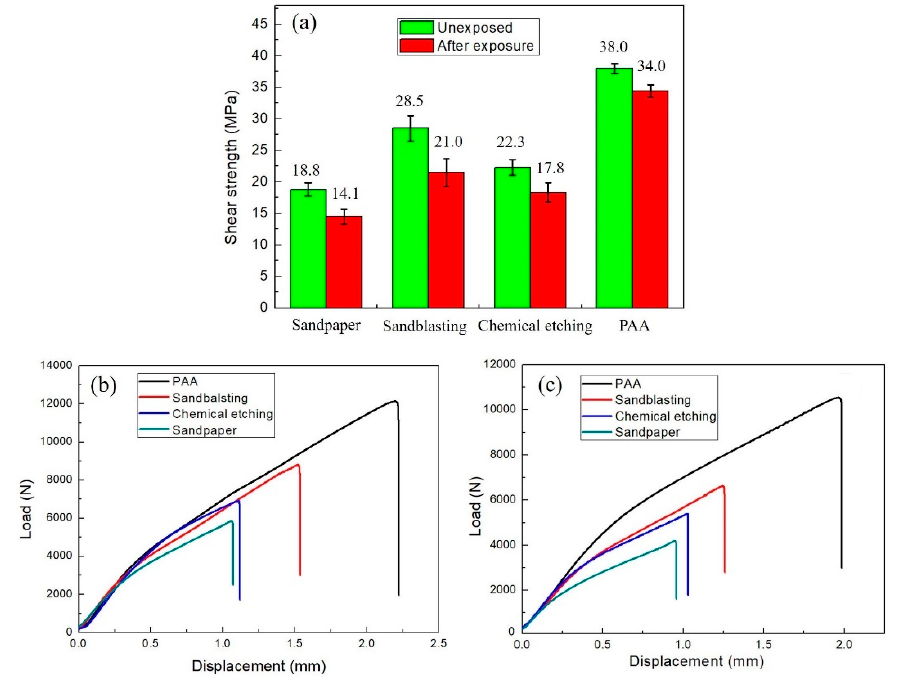
Figure 5. Effects of hot-humid exposure on joint strength: ( a ) strength degradation and load-displacement curves ( b ) before and ( c ) after exposure.